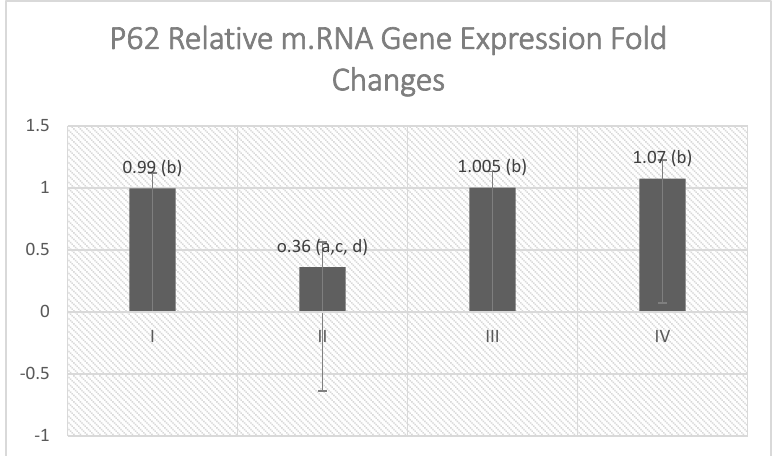
Figure 6. Effect of empagliflozin treatment on P62gene expression. Values are represented as mean ± SD (n = 10). a denotes a statistically significant difference compared to group I; b denotes a statistically significant difference compared to group II; c denotes a statistically significant difference compared to group III; d denotes a statistically significant difference compared to group IV, by one-way analysis of variance followed by post hoc Tukey’s test.